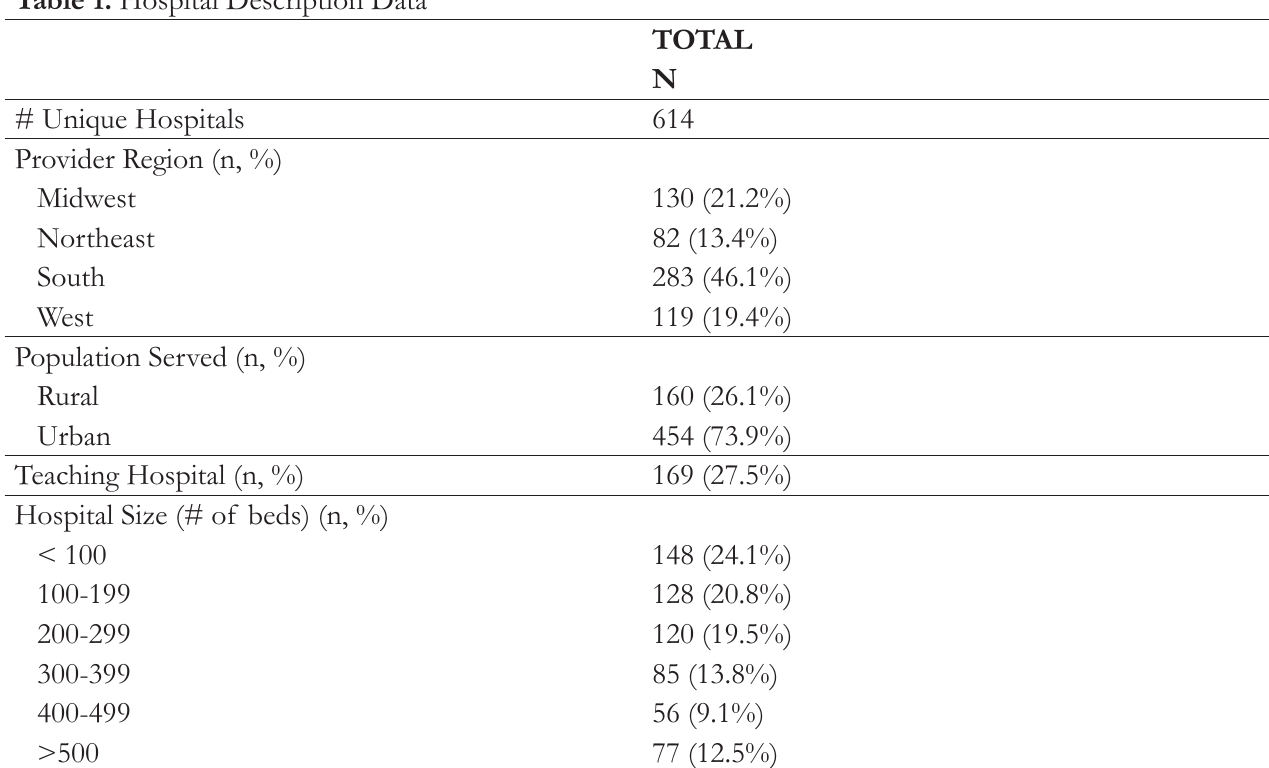
Table 1. Hospital Description